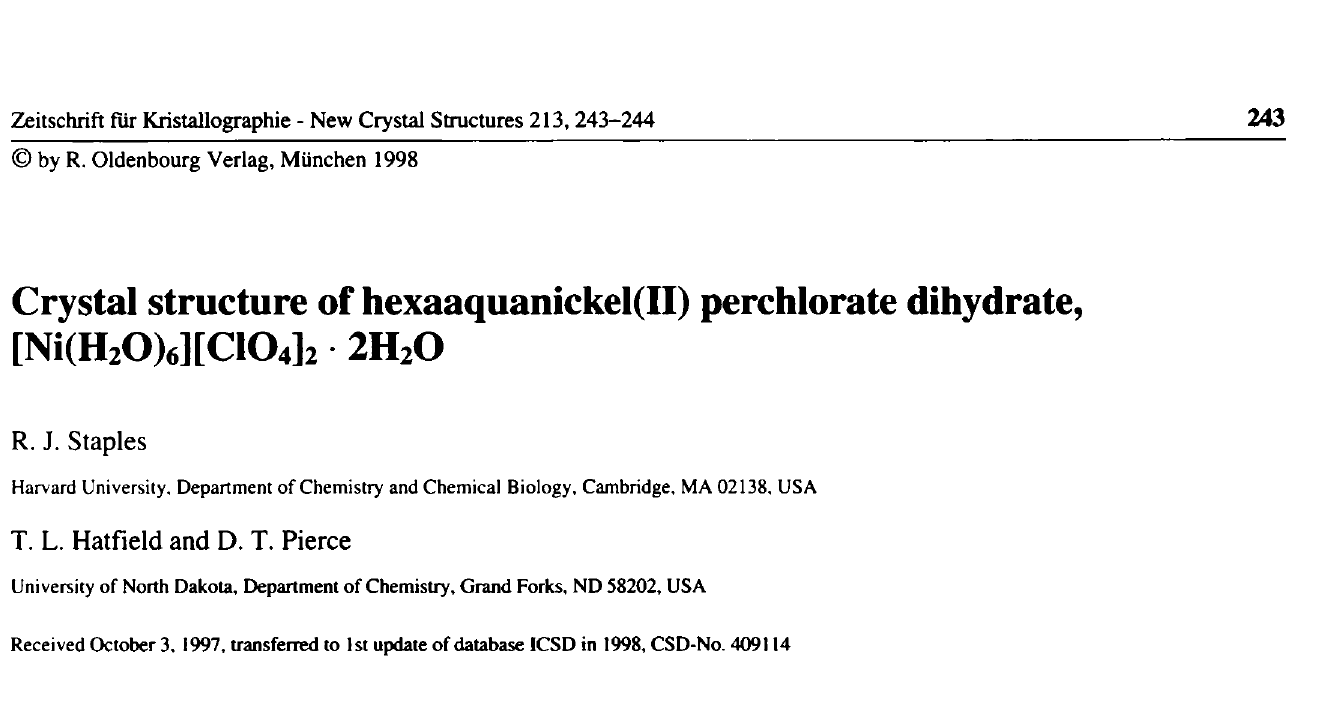
Table 1. Parameters used for the X-ray data collection Crystal: